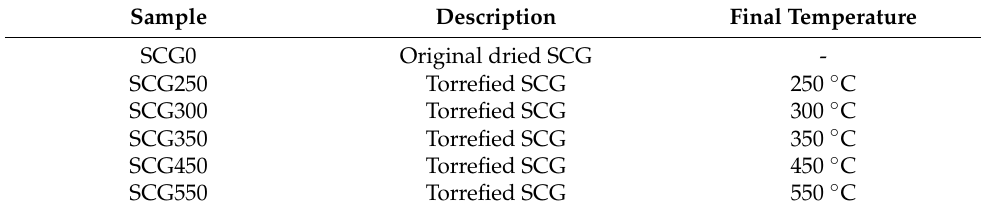
Table 1. List of samples Spent Coffee Ground